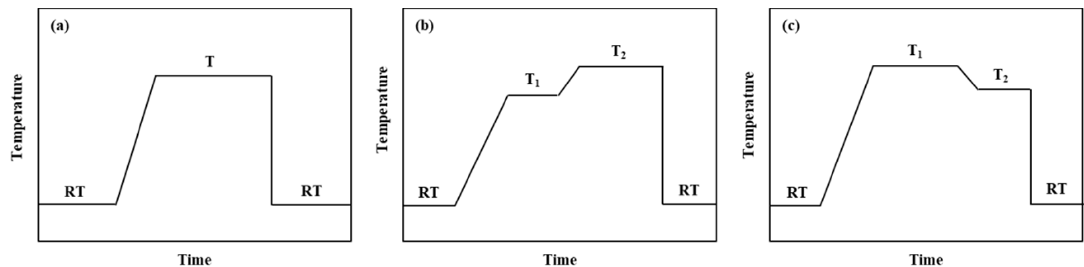
Figure 9. ( a ) Single-stage solid solution; ( b ) Stepwise temperature-increasing solution; ( c ) Near-solvus pre-precipitation following after high temperature solution [100–102].